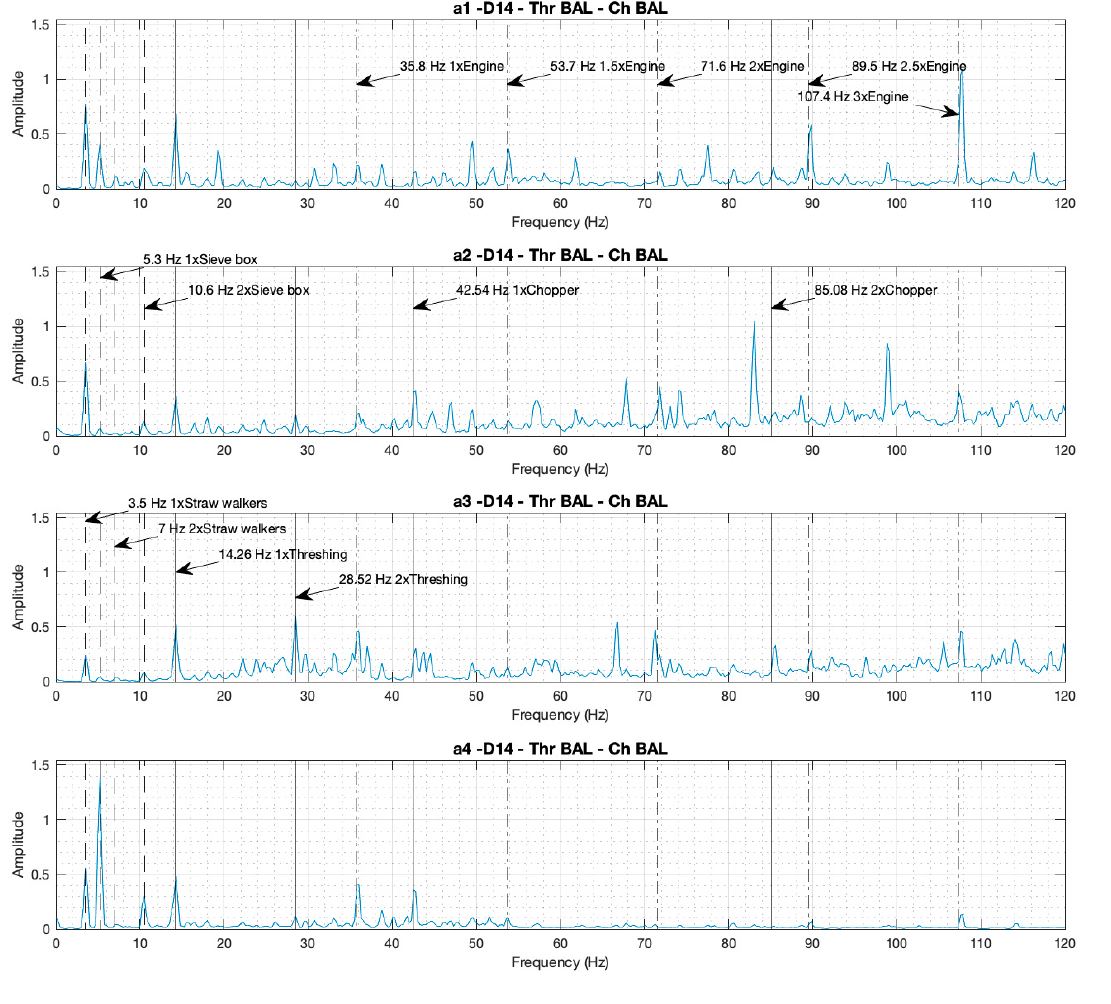
Figure 2. Individual spectra from the four accelerometers (a1–4), with the thresher and the chopper both engaged and balanced, with the motor at maximum rotational speed (Case D14).